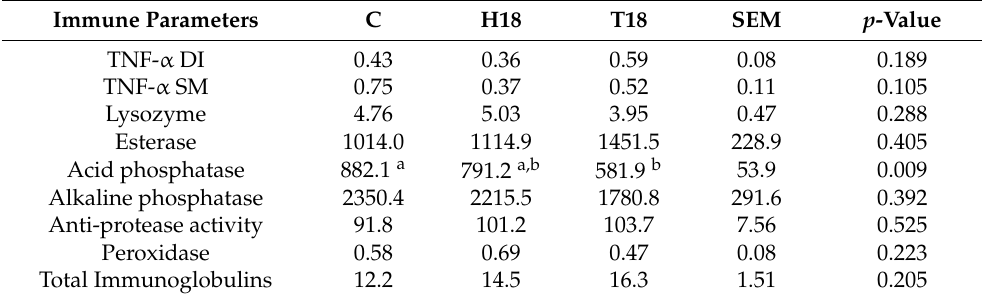
Table 6. Non-specific immune parameters of rainbow trout fed experimental